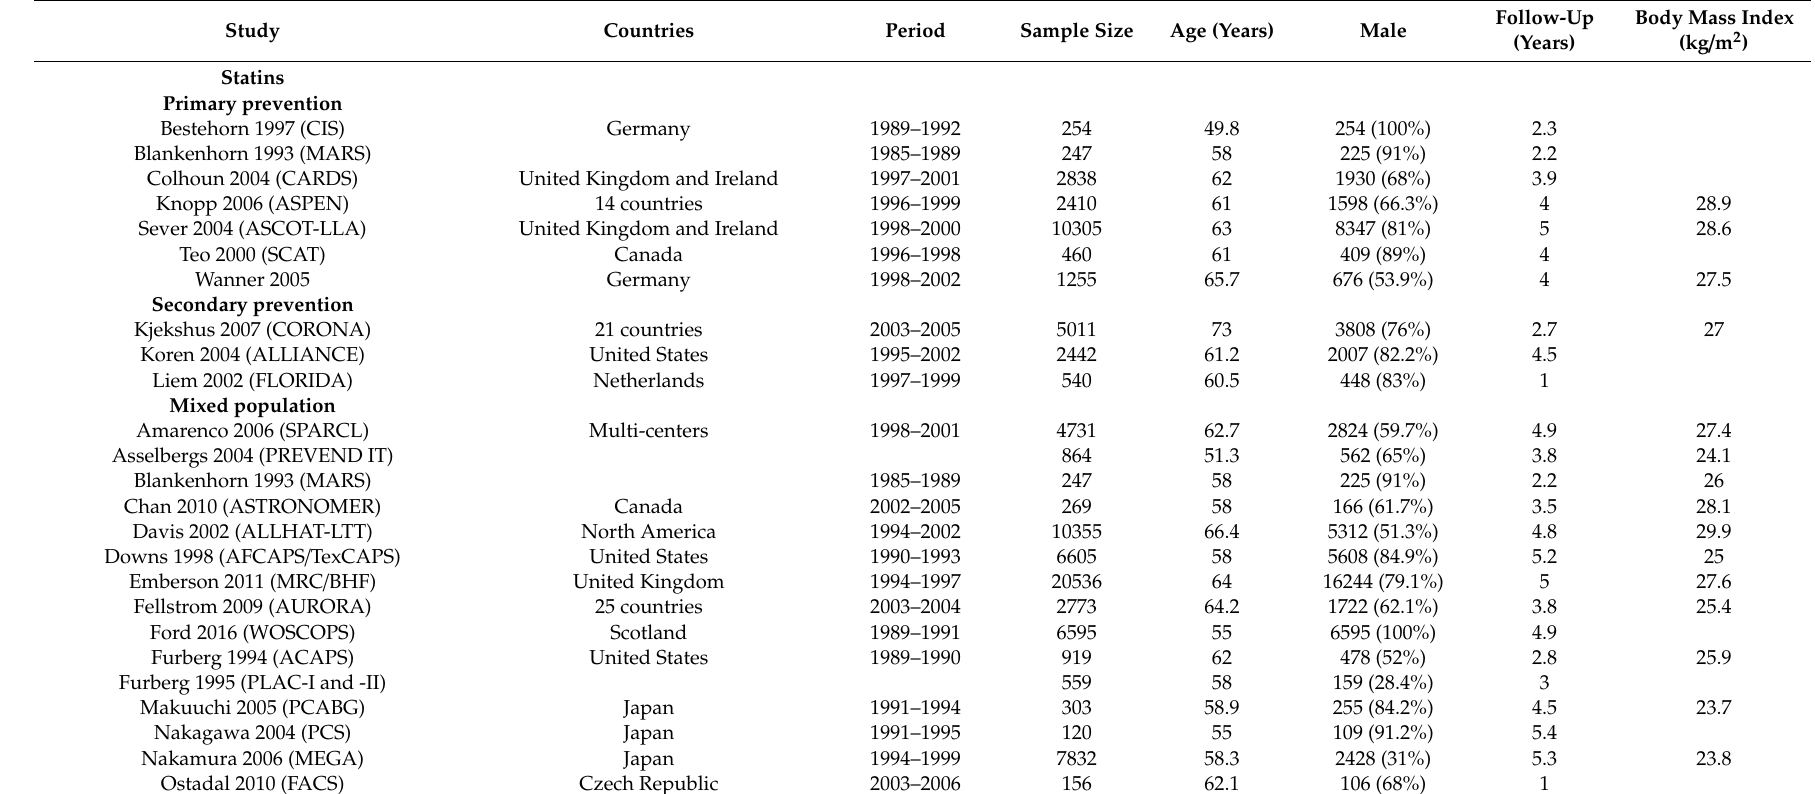
Table A1. General characteristics of the included randomized controlled